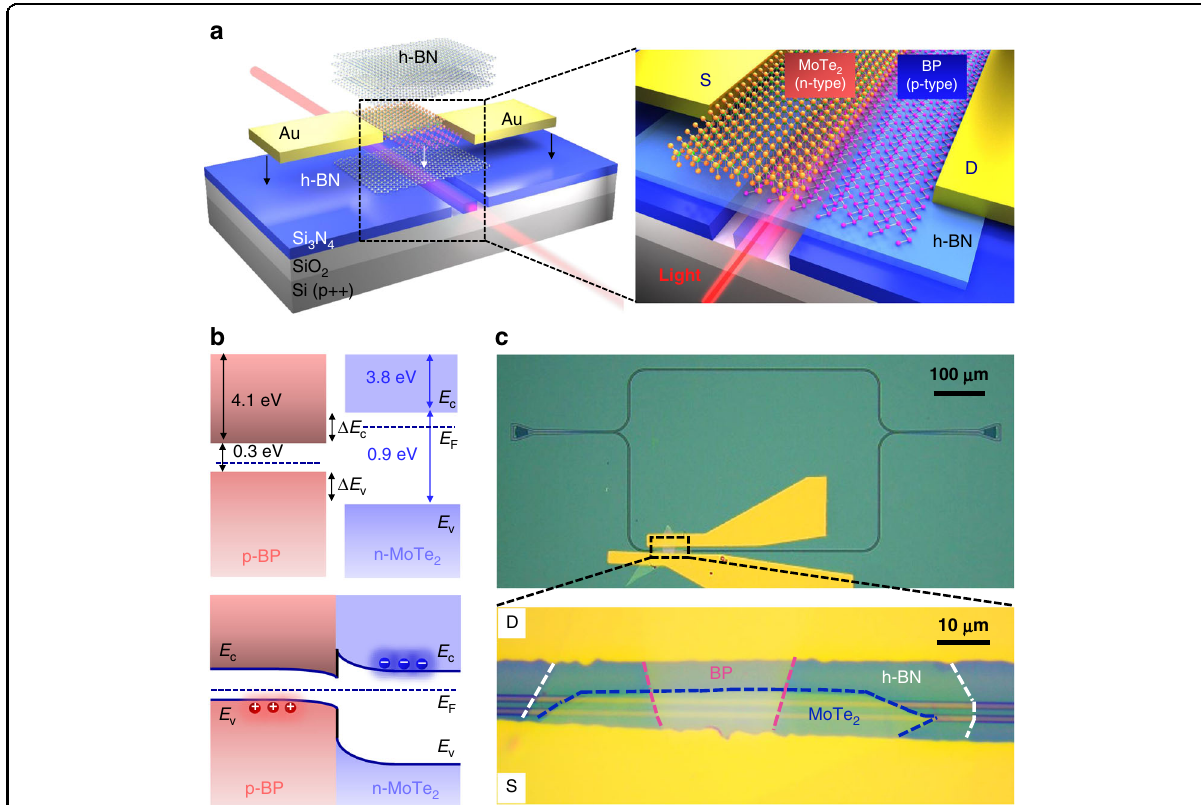
Fig. 1 BP/MoTe 2 van der Waals PN heterojunction photodetector integrated on a silicon nitride waveguide. a Schematic of the waveguide- integrated van der Waals PN heterojunction photodetector composed of stacking p-doped BP and n-doped MoTe 2 , which are evanescently coupled with the guiding mode of the silicon nitride waveguide. b Top: Band pro fi les of BP and MoTe 2 layers in the non-equilibrium state. Bottom: Band alignment of BP/MoTe 2 PN heterojunction in the thermal equilibrium state. c Top: Optical microscope image of the fabricated device, where a BP/ MoTe 2 heterojunction is integrated on one arm of a Mach – Zehnder interferometer. Bottom: Zoom-in view of the device indicated by the black square box in the top